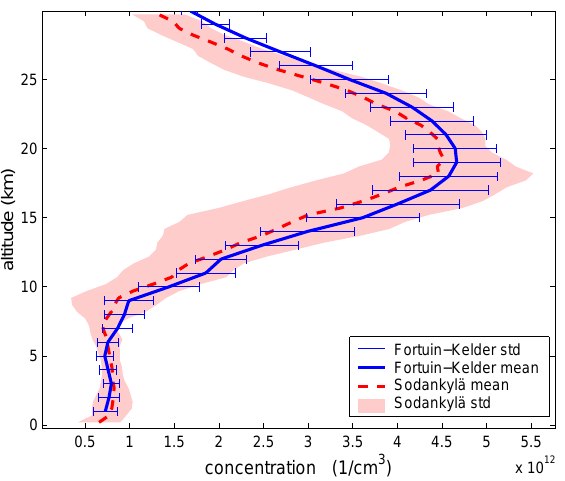
Fig. 4. Mean (dashed bold line) and standard deviation (shaded area) of ozone profile in November from analysis of ozone sonde data at Sodankyl¨a and monthly mean (bold solid line) and its standard deviation (error bars) from the Fortuin-Kelder